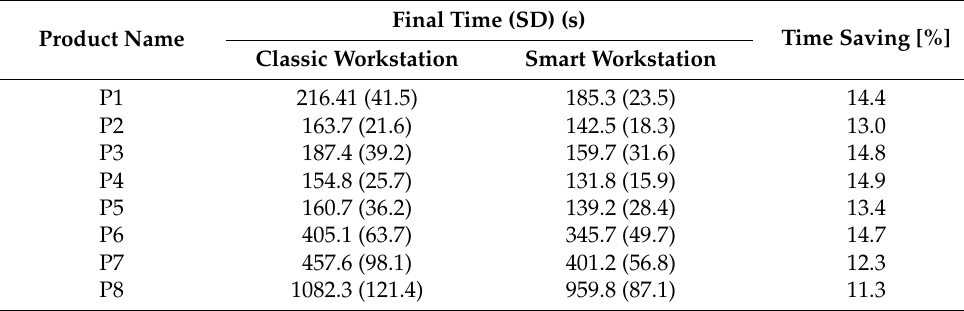
Table 2. Result of the time analysis.